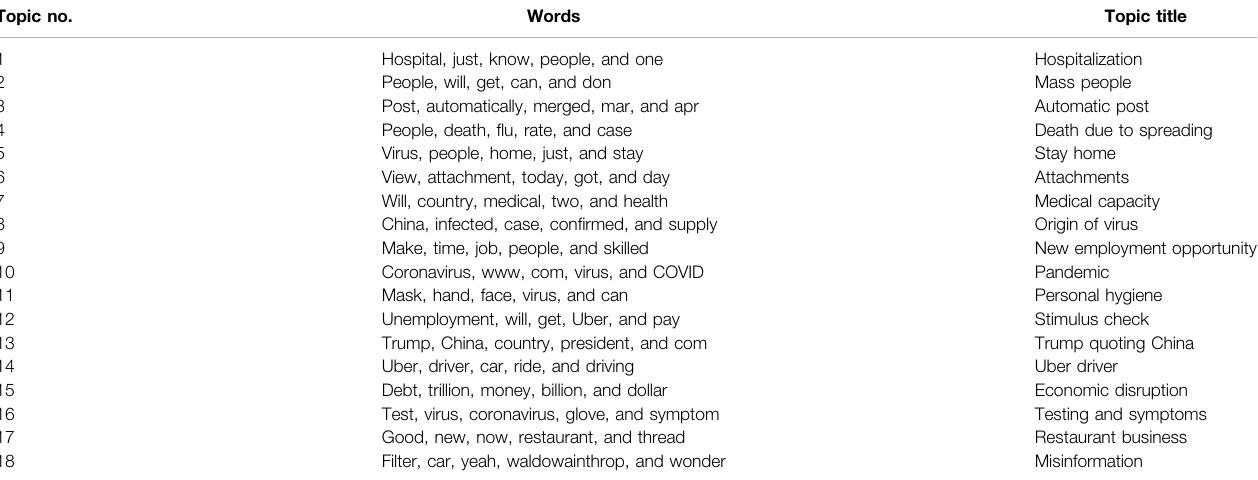
TABLE 4 | List of topics from topic model analysis of Corona forum. Topic